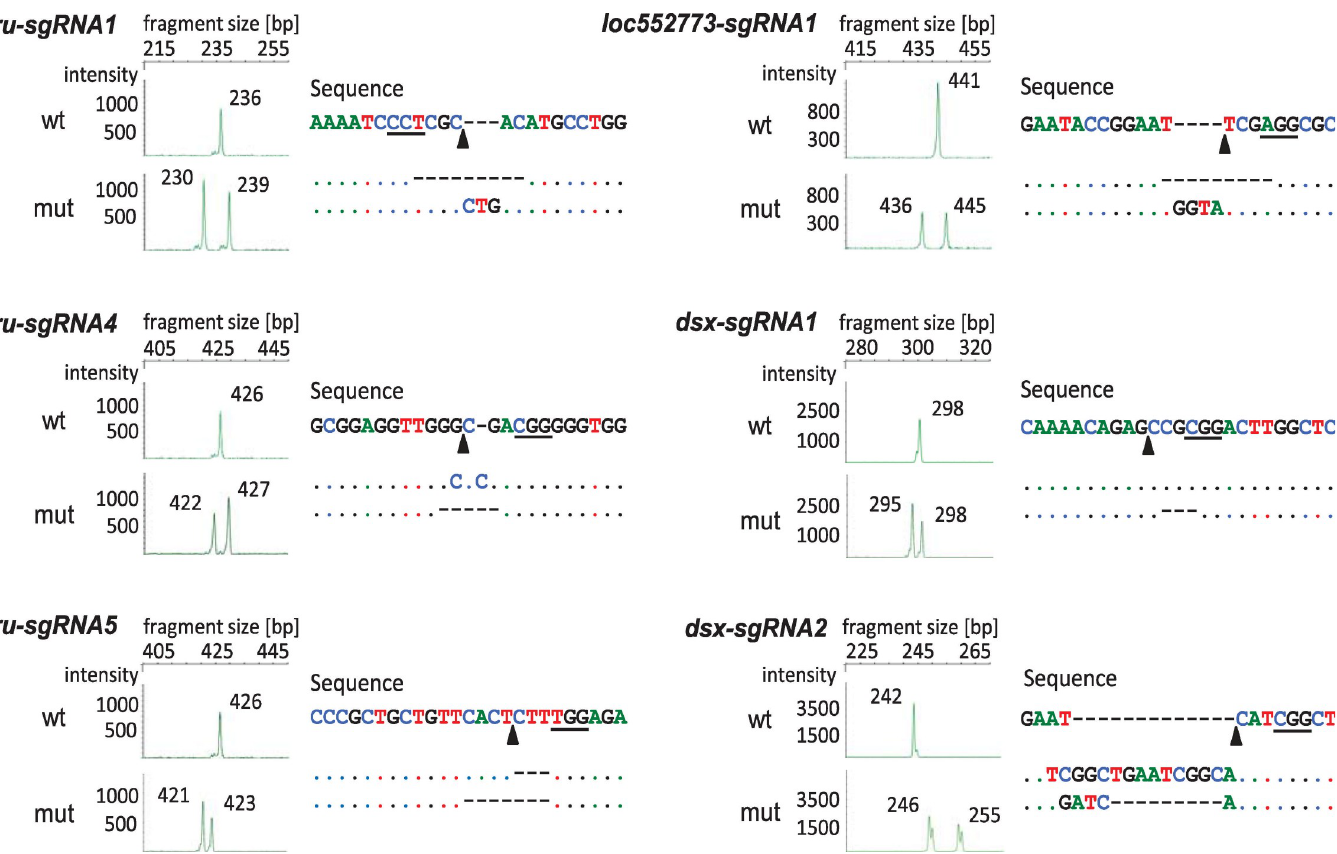
Fig 2. Examples of FL and nucleotide sequence analyses of the targeted genomic sites of single bees using the efficient CRISPR/Cas9 method. FL analysis is presented on the left, and the nucleotide sequences are presented on the right for single bees. Examples of WT alleles and mutated sequences are shown. The cleavage site of the Cas9 protein is indicated with arrows. The PAM site (the essential targeting component for CRISPR/Cas9) is underlined in the nucleotide sequence. Dashes indicate deletions. CRISPR/Cas9, clustered regularly interspaced short palindromic repeats/CRISPR-associated protein 9; FL, fragment length; mut, mutated sequences; PAM, Protospacer adjacent motif; WT, wild